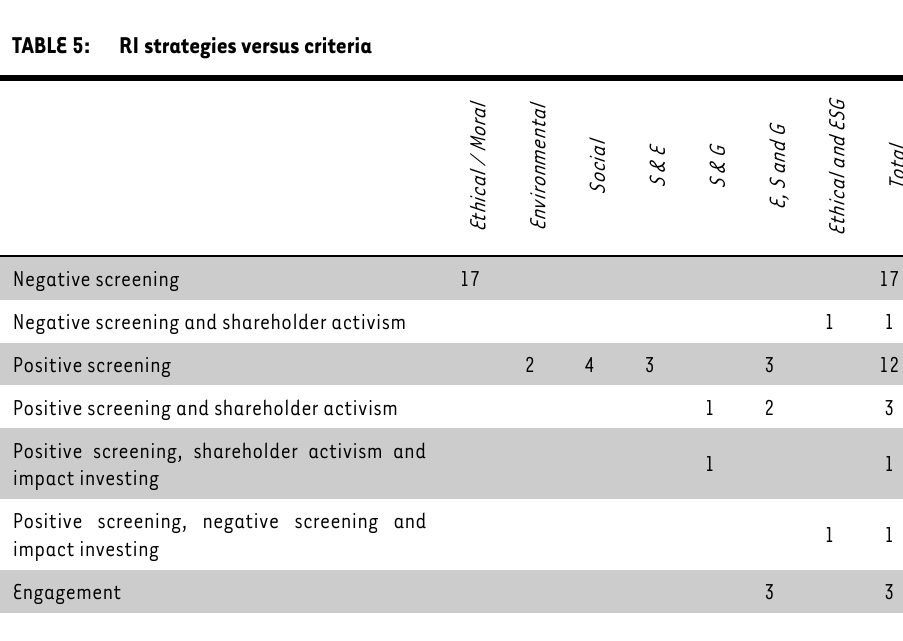
RI strategies versus criteria